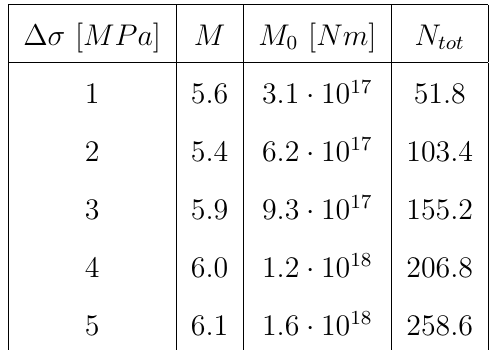
Table 5: Relation between fault parameters and aftershock production. The area of the fault is fixed at the value of 100 km 2 , the spacing is of 0 . 05 km ; the grid used in the computation has an area of 17 × 17 km 2 , the spacing on it is of 0 . 5 km .